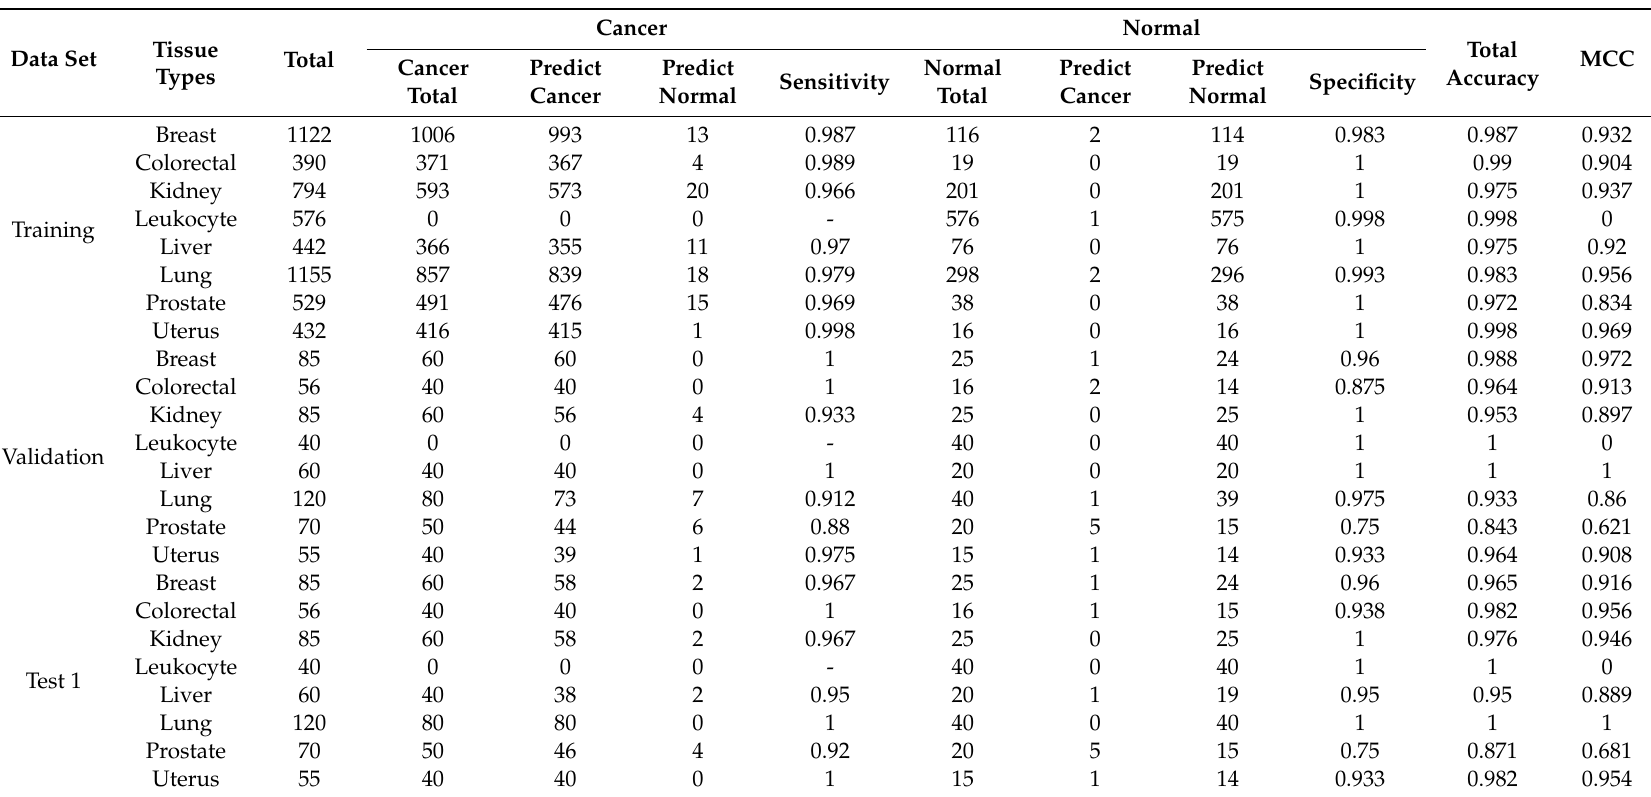
Table 4. The prediction results of three data sets for 12 CpG